Question: Does the plotted quantity increase or decrease?
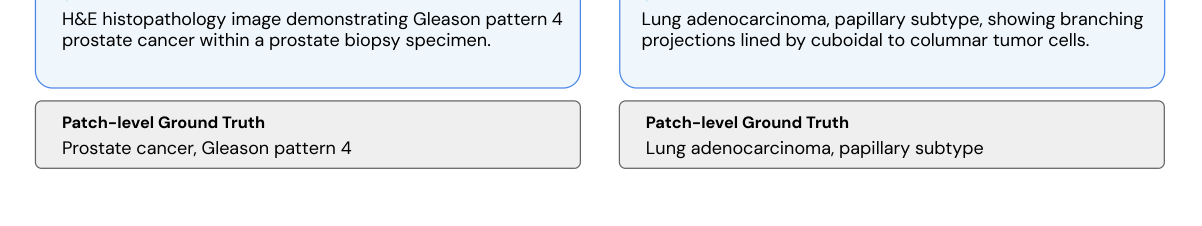
Answer: increasing